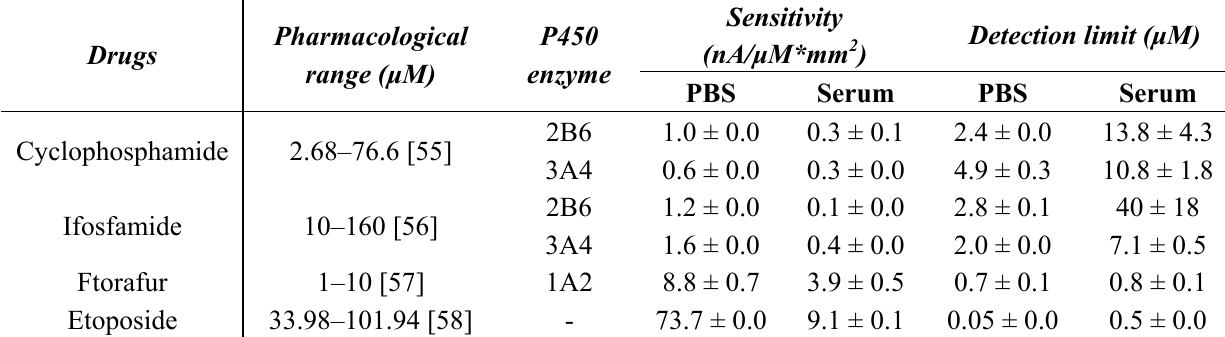
Table 3. Performances of electrodes nanostructured with CNTs and different CYP isoforms for drug